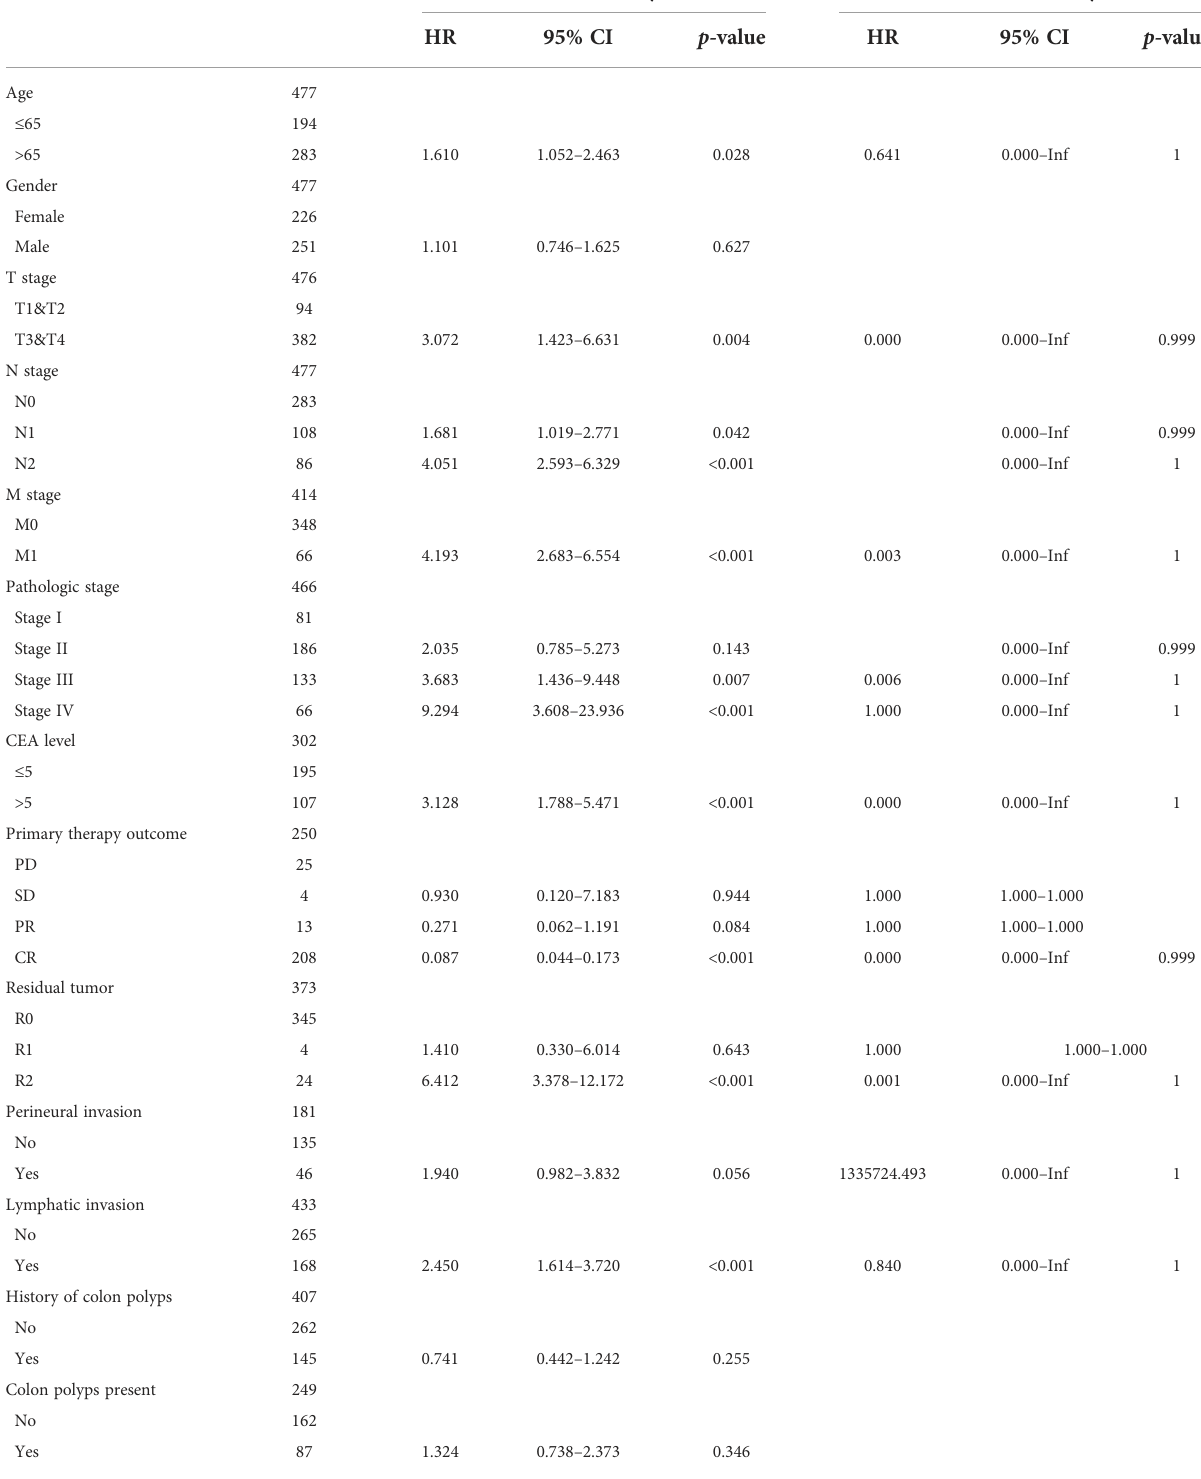
TABLE 1 Univariate Cox regression analyses and other clinicopathologic factors for OS in the entire TCGA